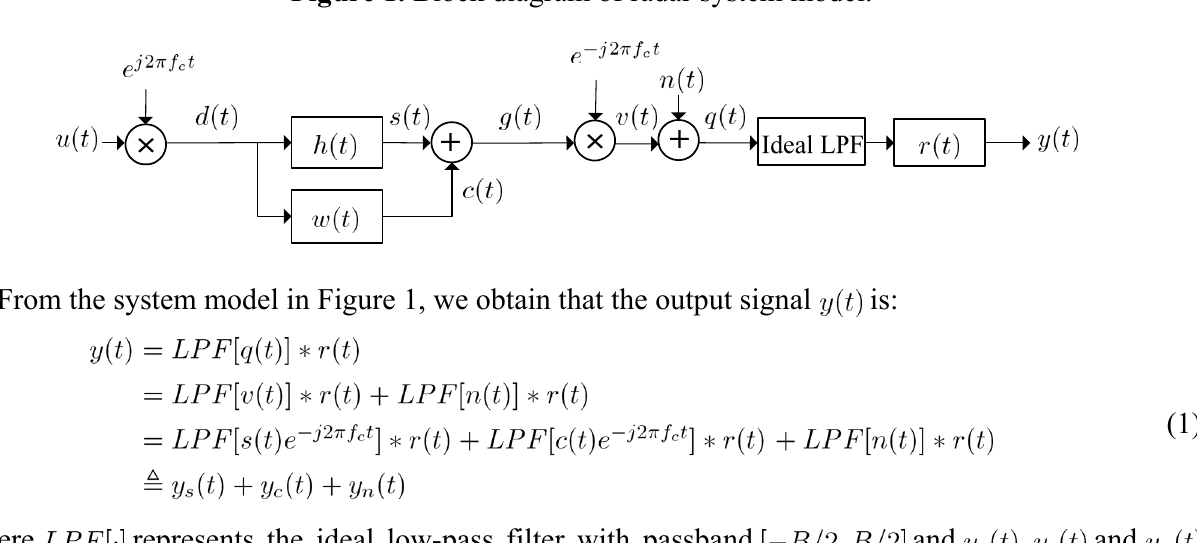
Figure 1. Block diagram of radar system